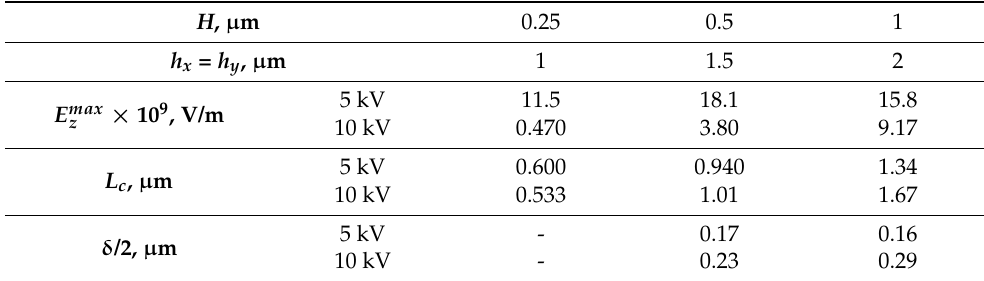
Figure 5. Distributions of electric field strength E z calculated for Scheme A and a dose of 5000 µ C/cm 2 . Left— U = 5 kV, right— U = 10 kV. The numbers 1, 2, and 3 represent variants with H = 0.25 µ m, H = 0.5 µ m and H = 1 µ m, respectively. ( a , b ) The distributions of E z by depth in the center of the squares. ( c , d ) Contours of zones where E z has values not less than 0.9 E max z , 0.6 E max z , 0.3 E max z , and E c . These contours are colored red, green, blue, and orange, respectively. The upper row is the contours obtained by crossing the zones with the XY plane in the positions where these zones have the maximum cross-section. The images are presented in regions of h x × h y size. The bottom row is the contours of the zones in the YZ plane passing through the center of the squares. Black bar marks correspond to the length H . Table 1. Values of E max z L c , and δ /2 at h x = h y . See also the